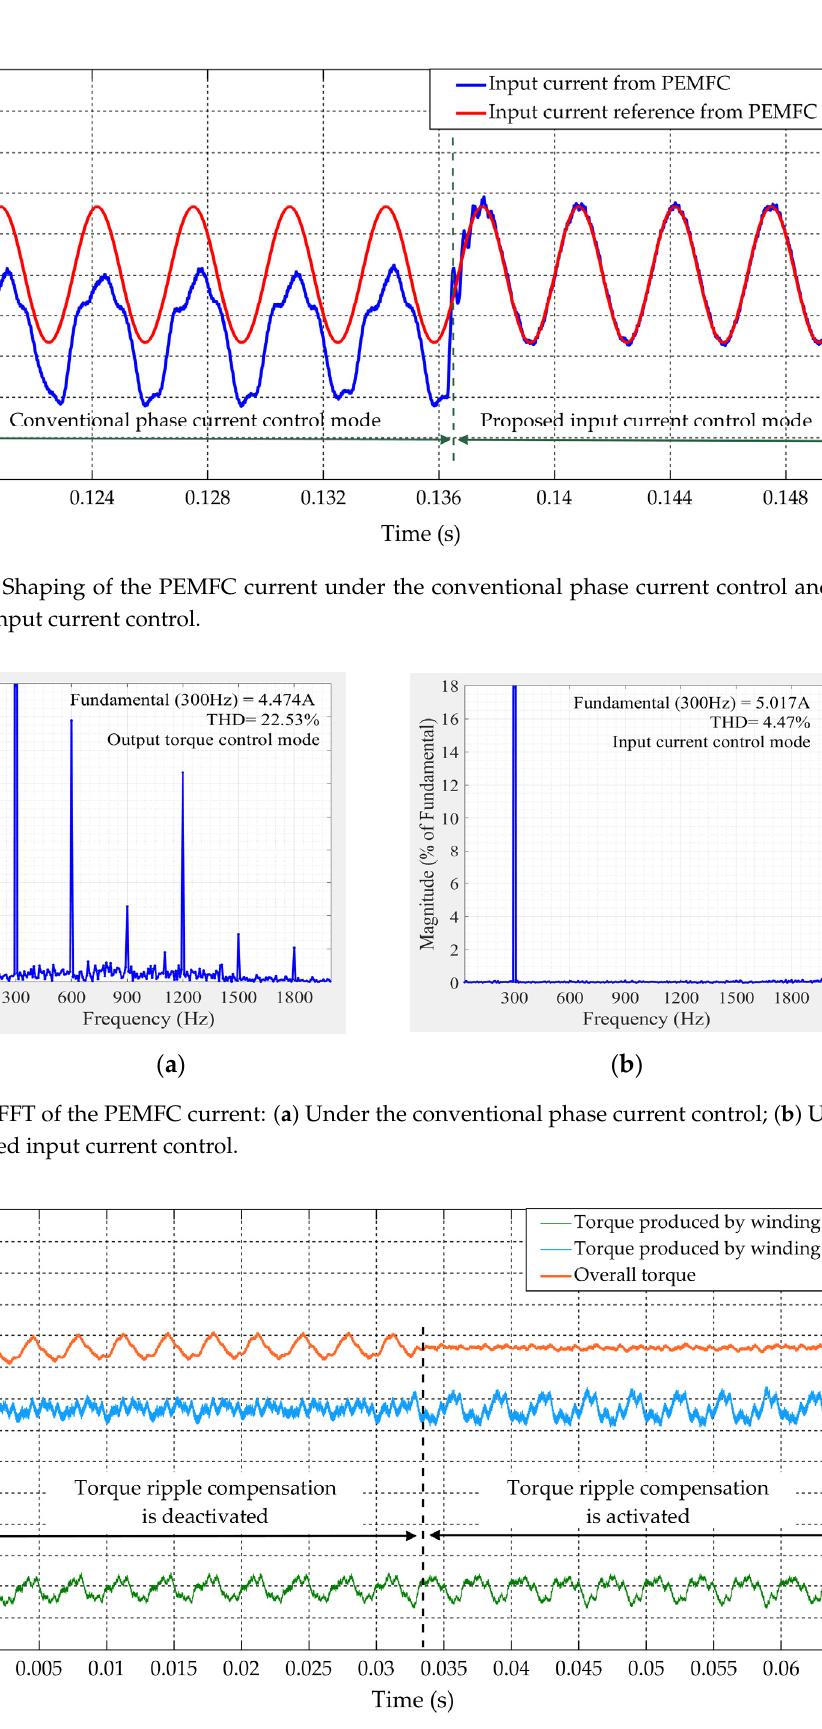
Figure 13. Suppression of the torque ripple under the HFR measurement condition.